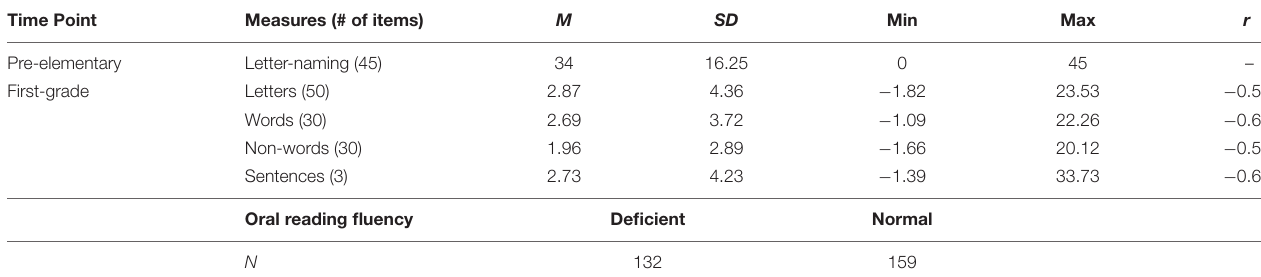
TABLE 2 | Descriptive statistics of letter-naming and measures of oral reading